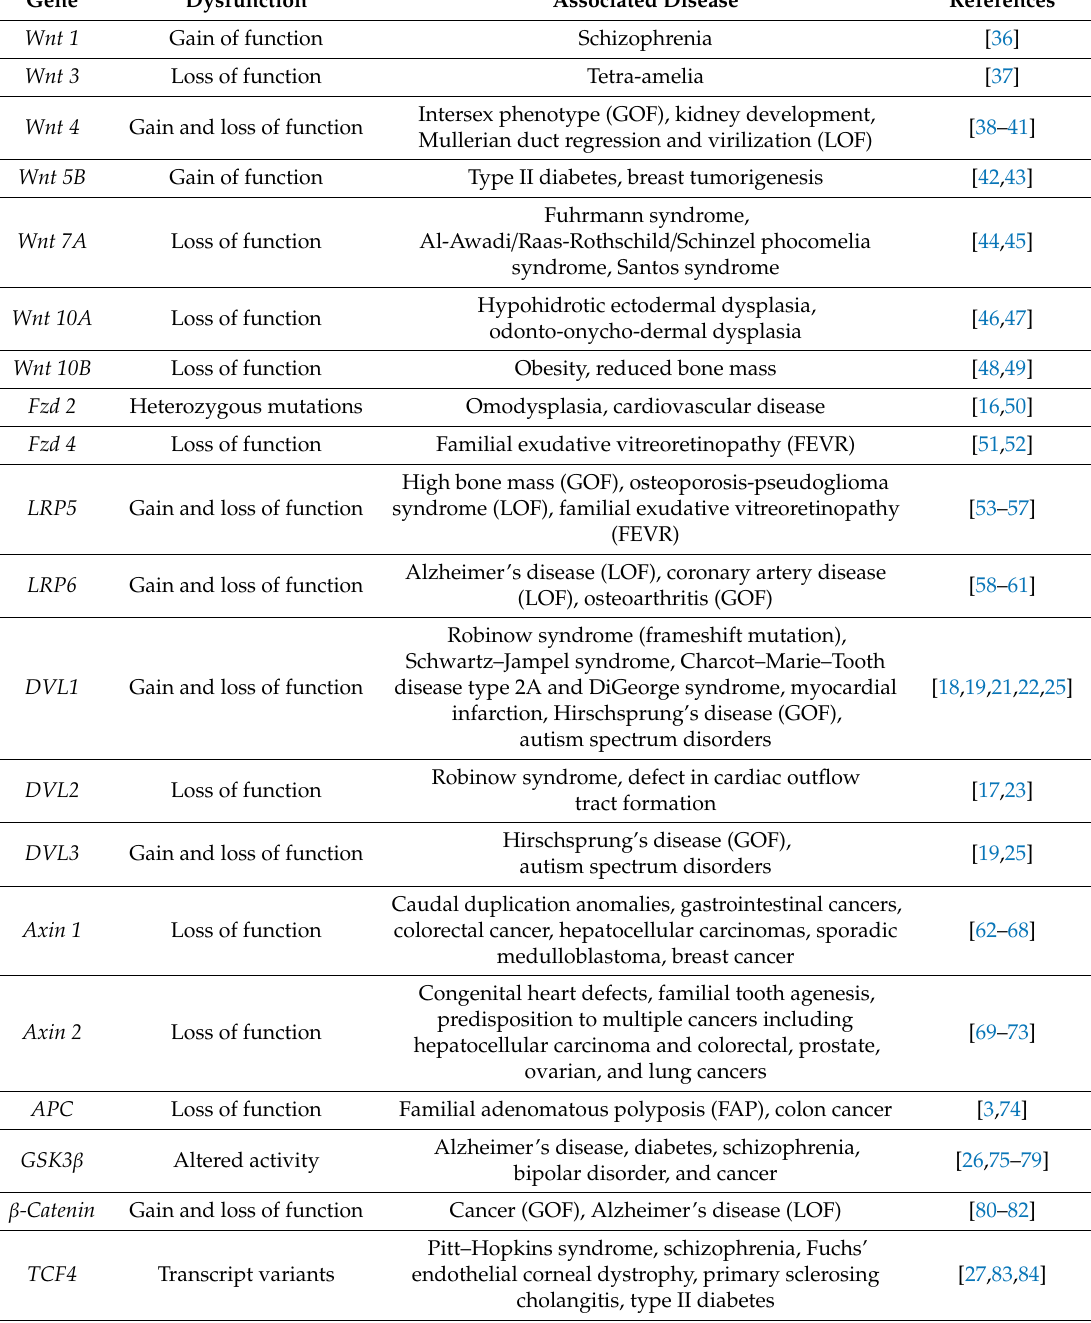
Table 1. Human diseases associated with dysregulation in Wnt signaling